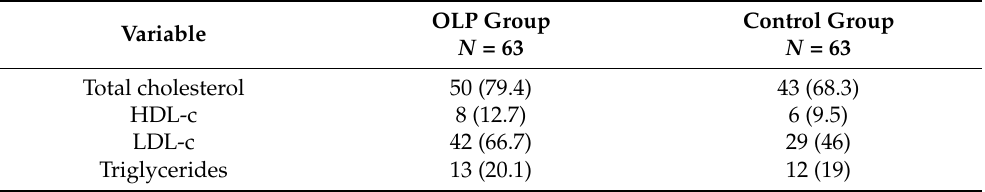
Table 2. Differences in cholesterol and triglyceride values that exceeded normal ranges between subjects with oral lichen planus and the control